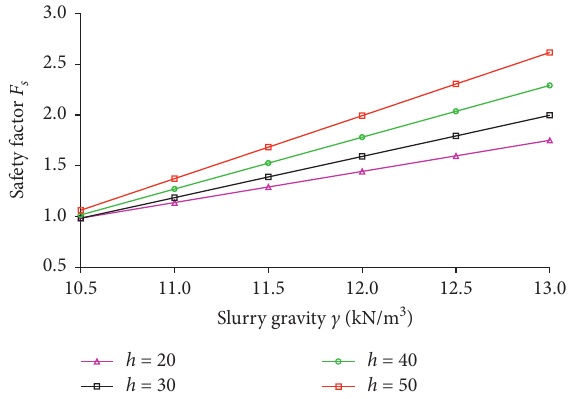
Figure 9: Relationship between the safety factor and slurry gravity.